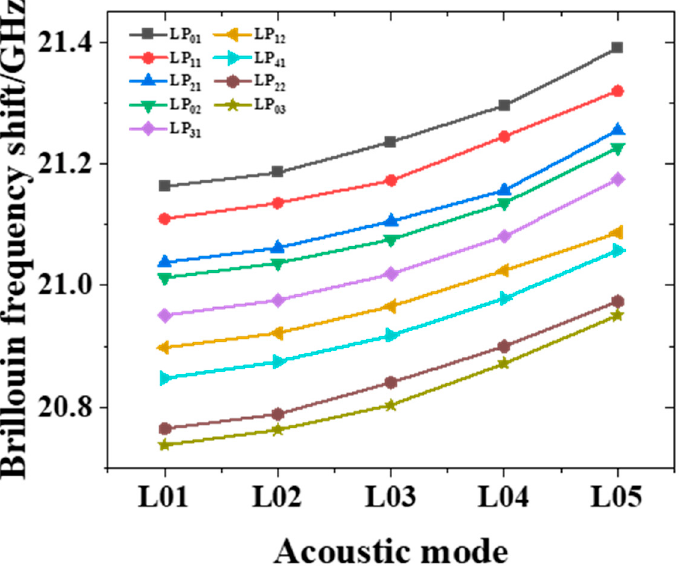
Figure 4. BFS characteristics of L (cid:2868)(cid:3041) acoustic mode in the case of nine LP (cid:3040)(cid:3041) - LP (cid:3040)(cid:3041) mode pairs.